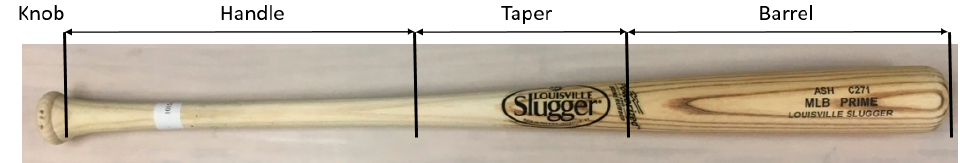
Figure 1. Ash baseball bat with logo on the face-grain surface of the bat. The knob, handle, taper and barrel sections of the bat are identified.